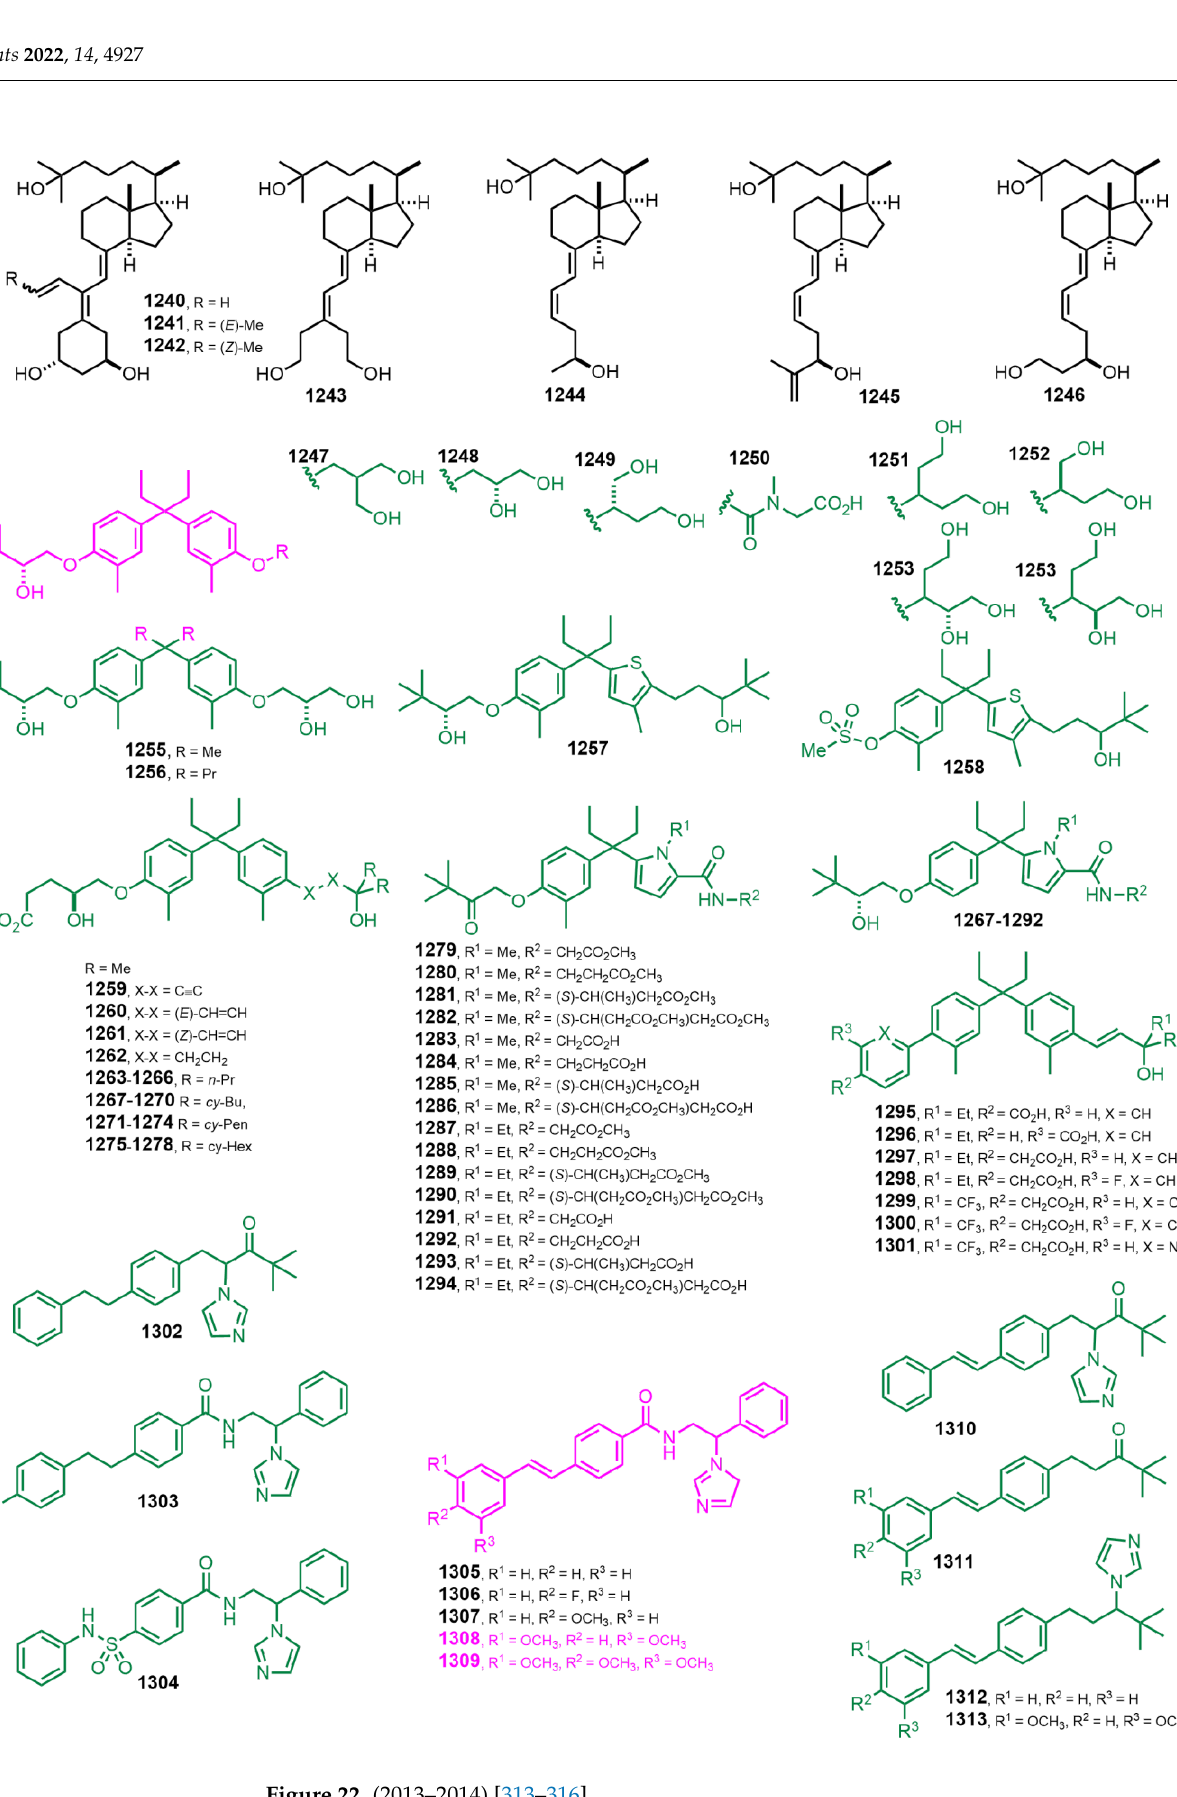
Figure 22. (2013–2014)